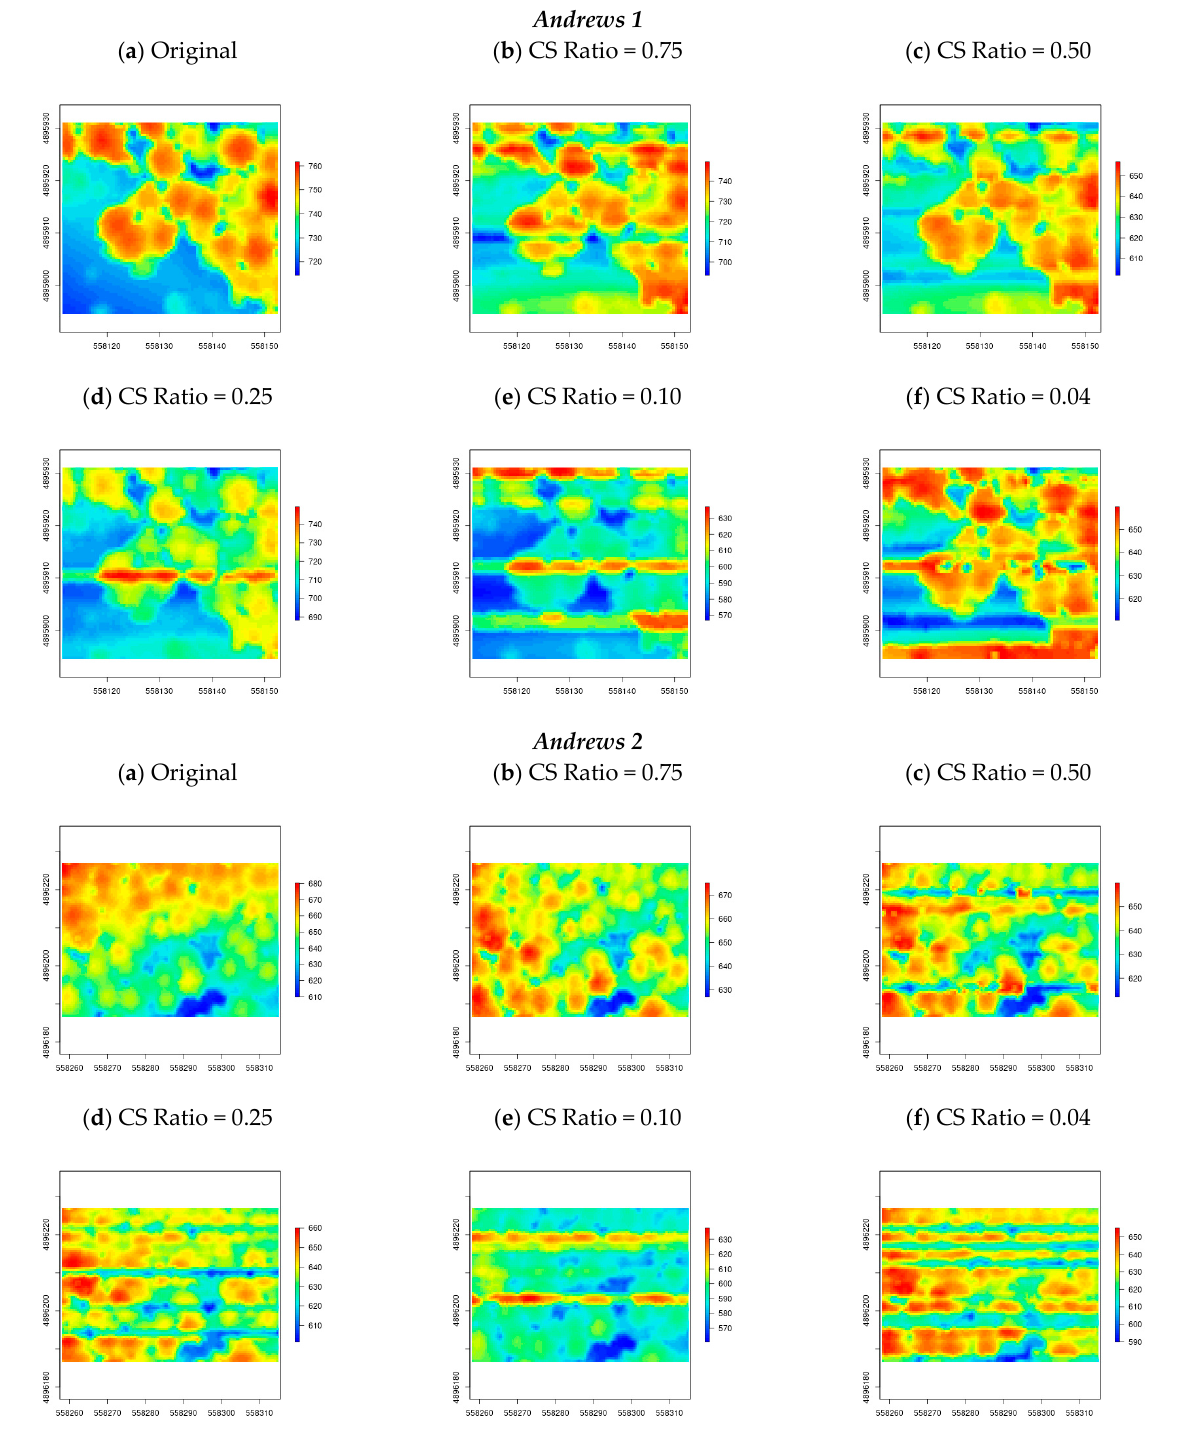
Figure 10. Visualization of the generated Canopy Height Model (CHM) of the original and recon- structed 3D LiDAR point clouds using the proposed ADCoSNet for the Andrews 1 and Andrews 2 test site. ( a ) Original; ( b ) CS Ratio = 0.75; ( c ) CS Ratio = 0.50; ( d ) CS Ratio = 0.25; ( e ) CS Ratio = 0.10; ( f ) CS Ratio = 0.04.